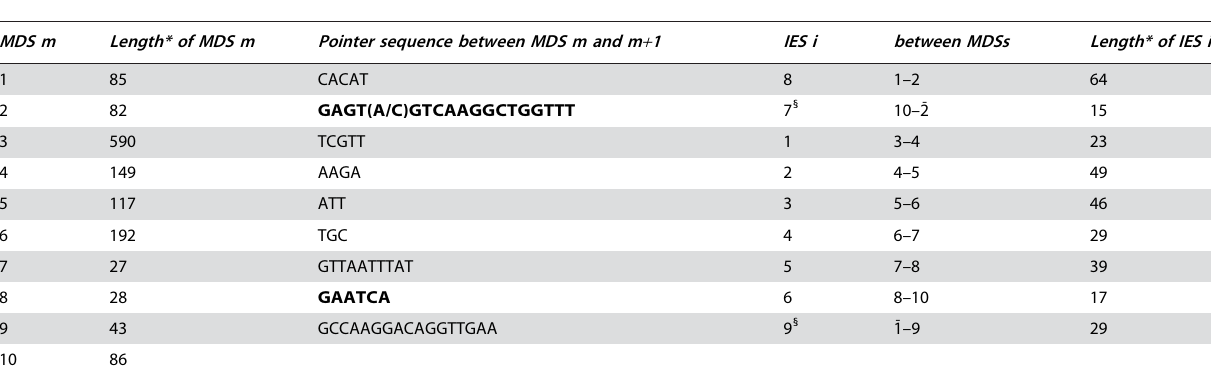
Table 1. Characteristics of MDSs, IESs, and pointers of the S. lemnae actin I gene.